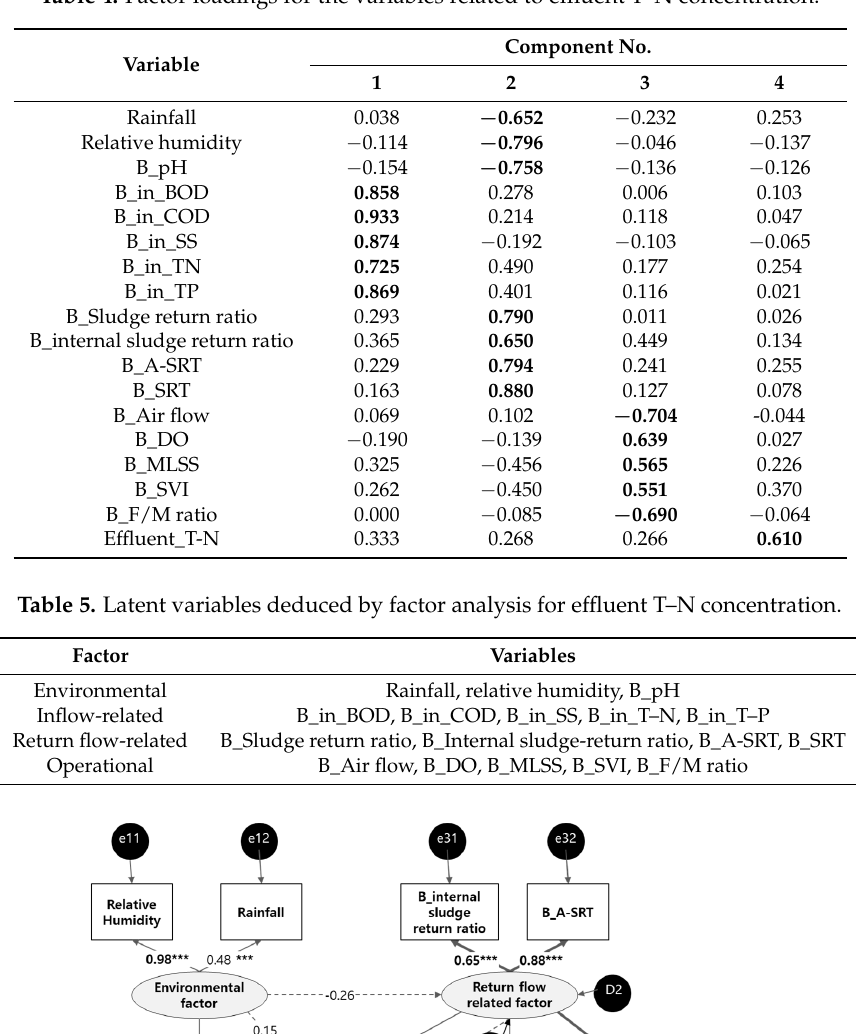
Table 4. Factor loadings for the variables related to effluent T–N concentration.